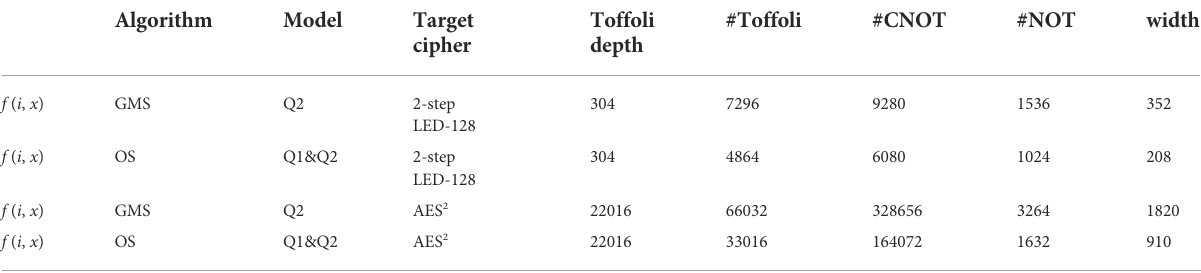
TABLE 5 Resource estimation for constructed functions of target ciphers, where #Toffoli/CNOT/NOT represents the number of Toffoli gates, CNOT gates and NOT gates respectively. Algorithm